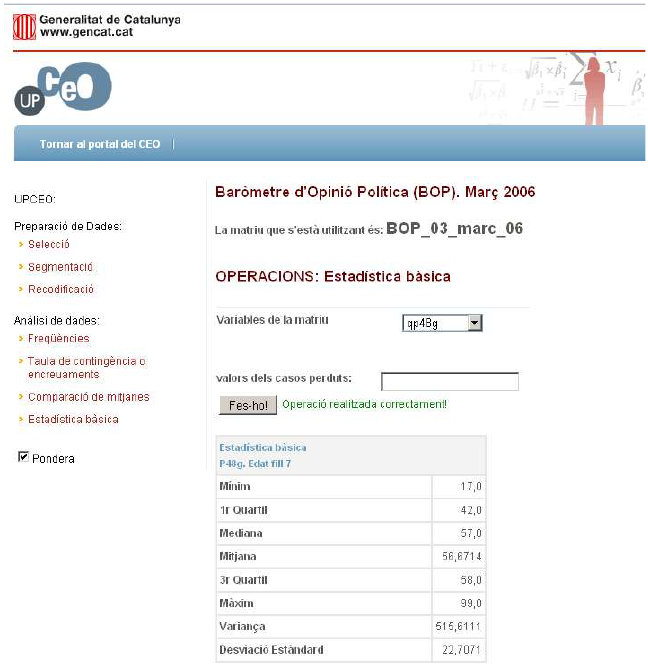
Figure 14. Basic statistics results.